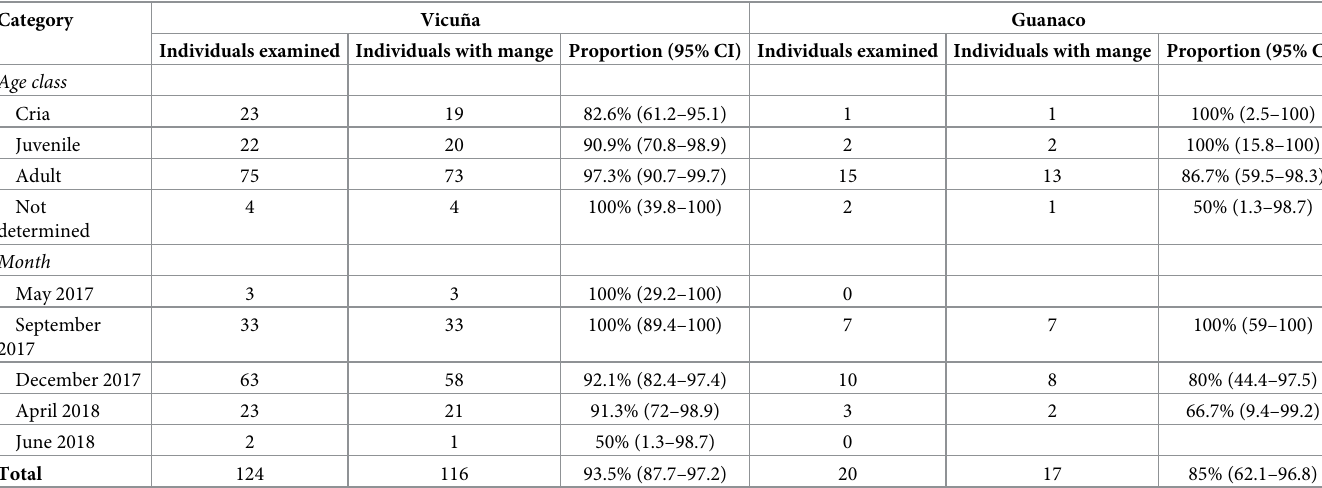
Table 2. Number and proportion of mange in examined vicu ñ a and guanaco carcasses at San Guillermo National Park, May 2017 –June 2018.